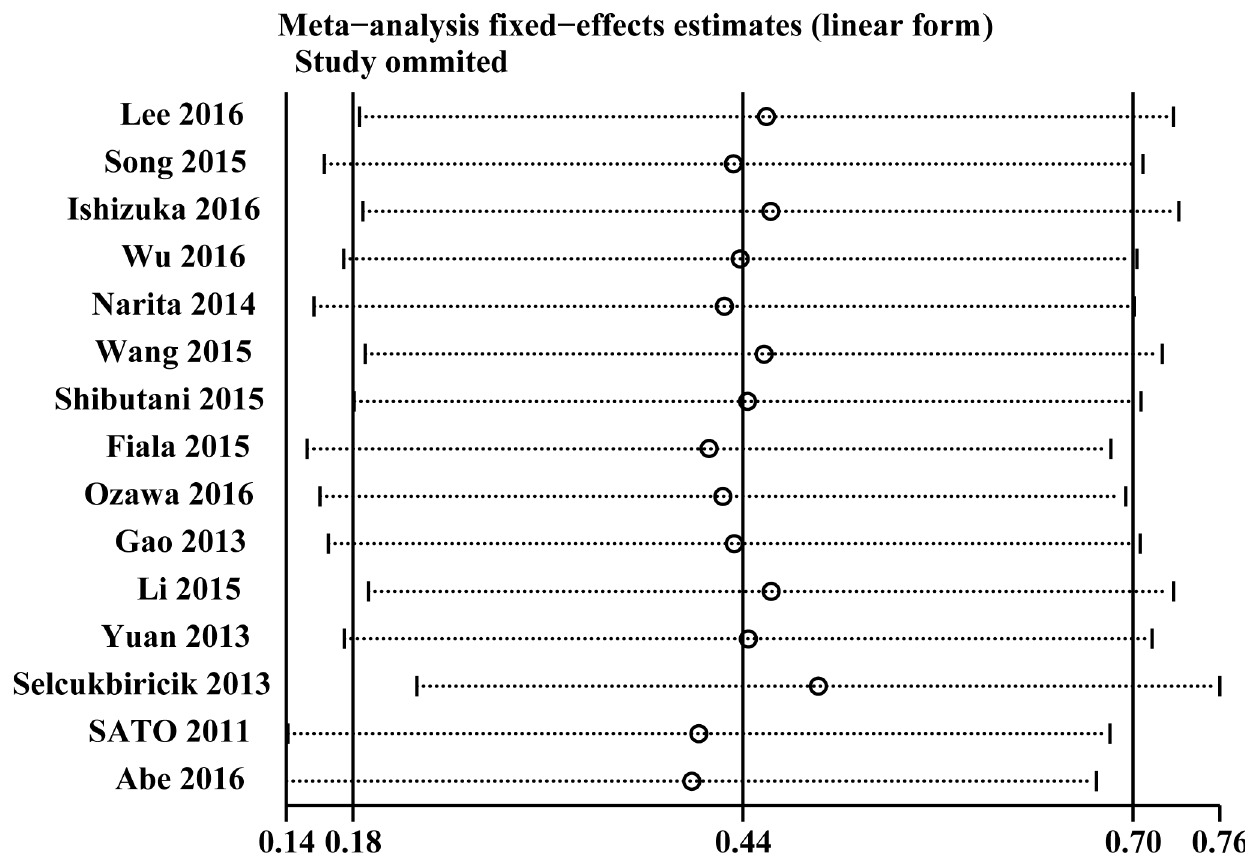
Fig 3. Sensitivity analysesfor confirming robustness of OS by removing 1 study each time.